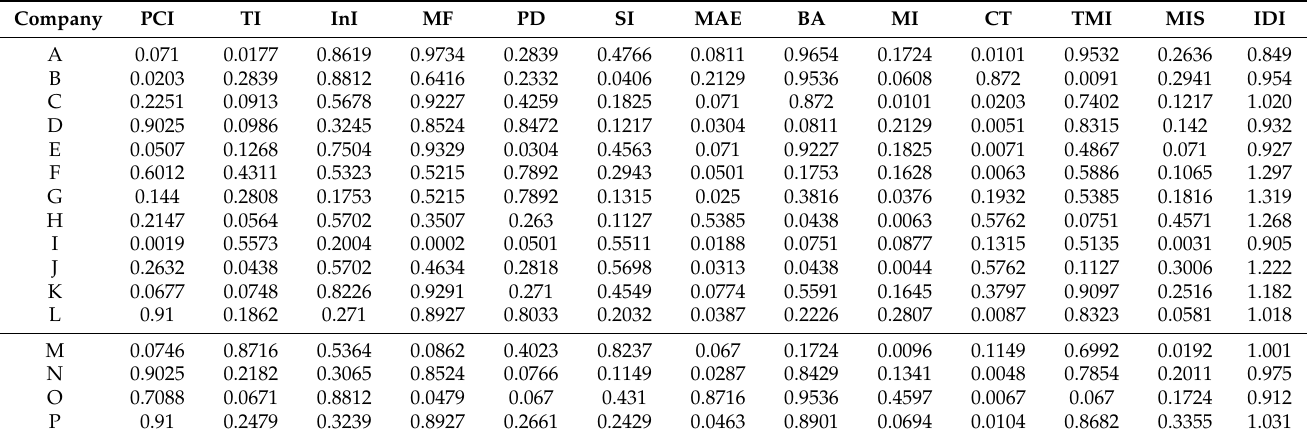
Table 7. Results of integrated enterprise development according to the potential exchange.